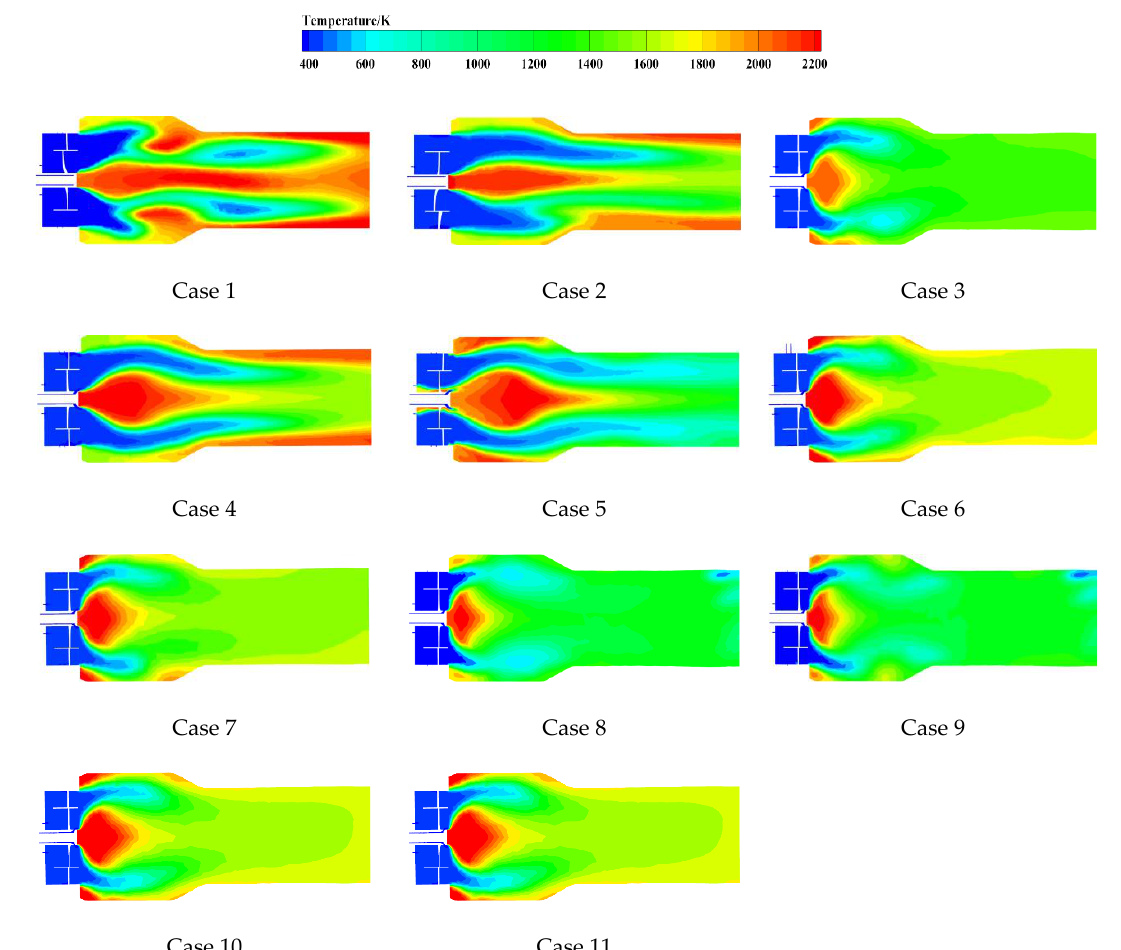
Figure 7. The temperature distribution time-averaged for different cases.